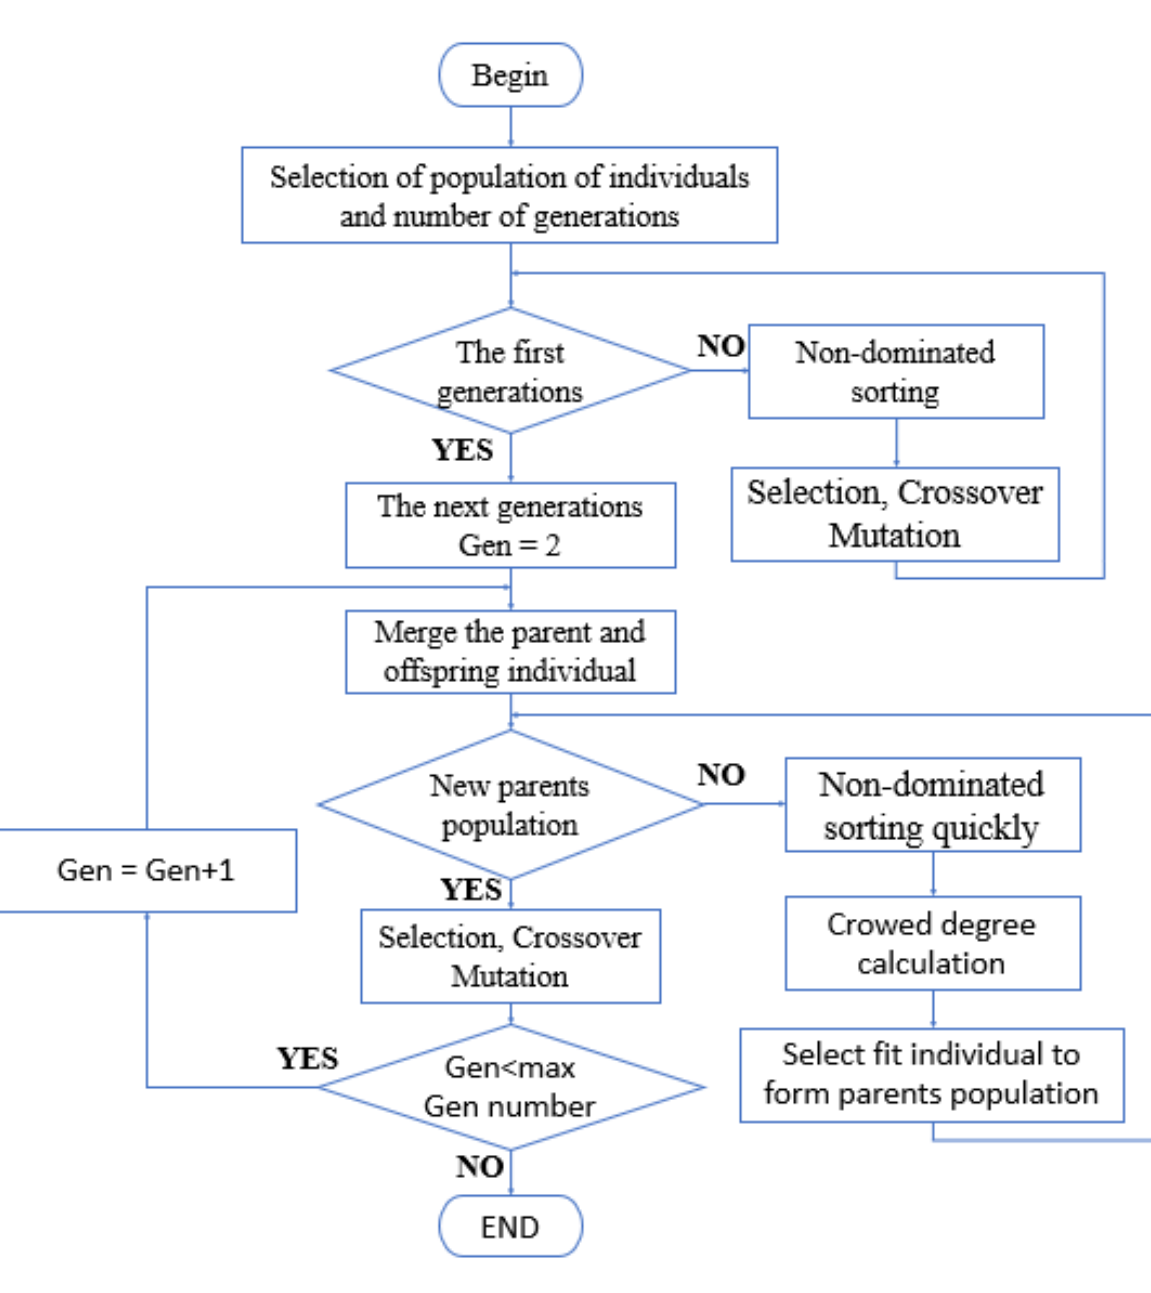
Figure 6. NSGA-II optimization algorithm flow chart.